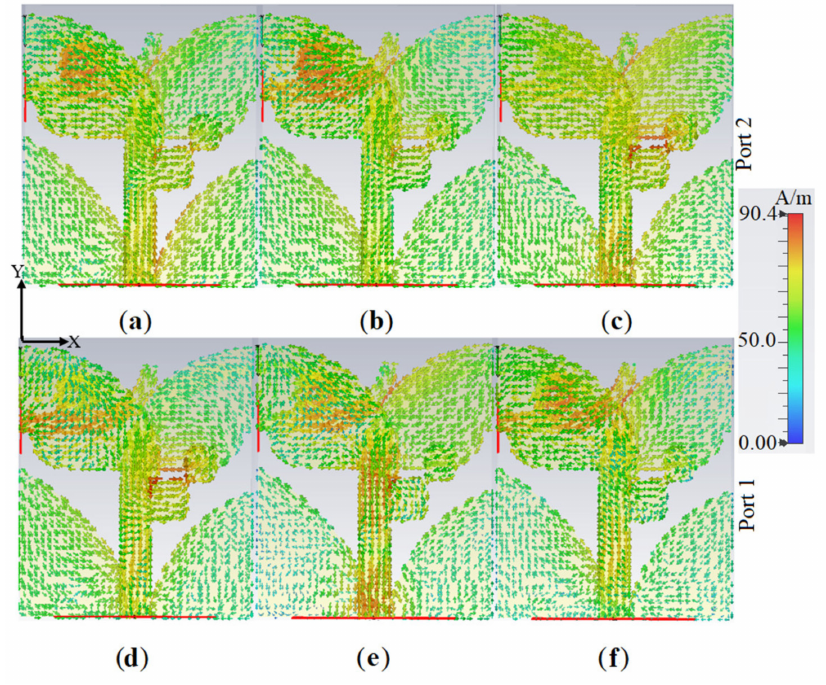
Figure 8. The proposed antenna’s surface current density (SCD) variations: ( a , d ) 3.8 GHz, ( b , e ) 5.2 GHz, and ( c , f ) 8.0 GHz) (red color is maximum and blue is the